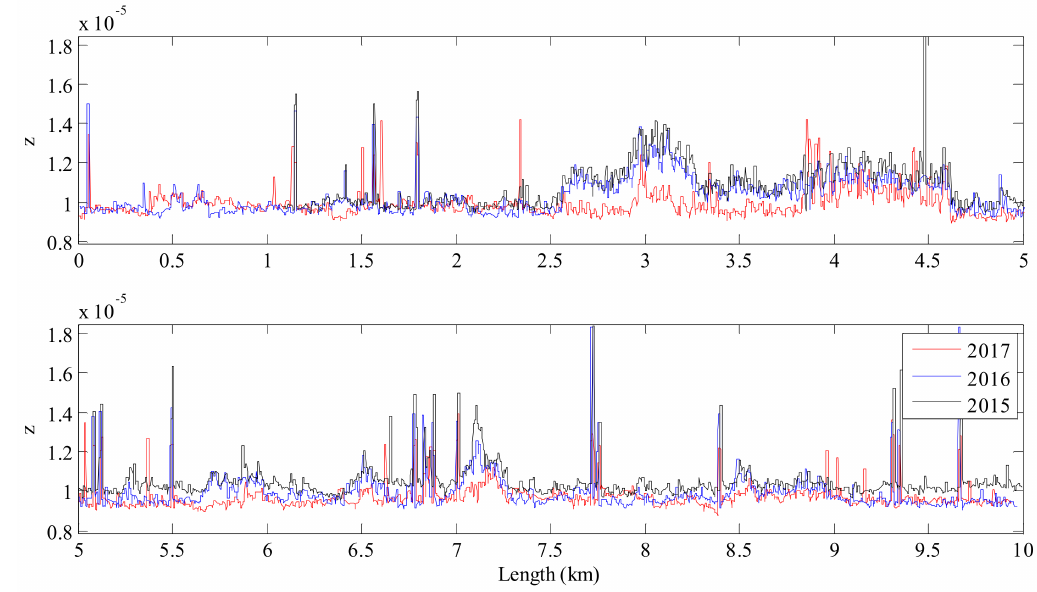
Figure 7. GPR parameter z , in the time domain, regarding data from the summers of 2015, 2016 and